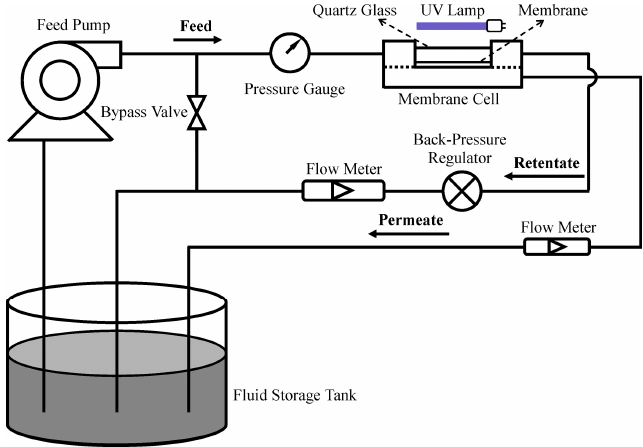
Figure 4. Schematic diagram of a lab scale PMR operated in cross flow mode with both the permeate and the retentate returned back into the feed tank. Adapted with permission from [59], Copyright Elsevier, 2014.